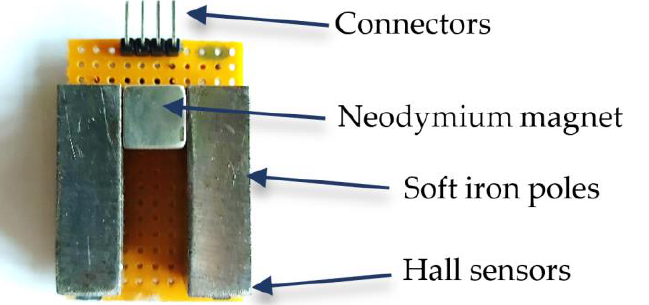
Figure 10. Sensing arrangement consisting of a cubic permanent magnet, two ferromagnetic poles, and two Hall sensors.